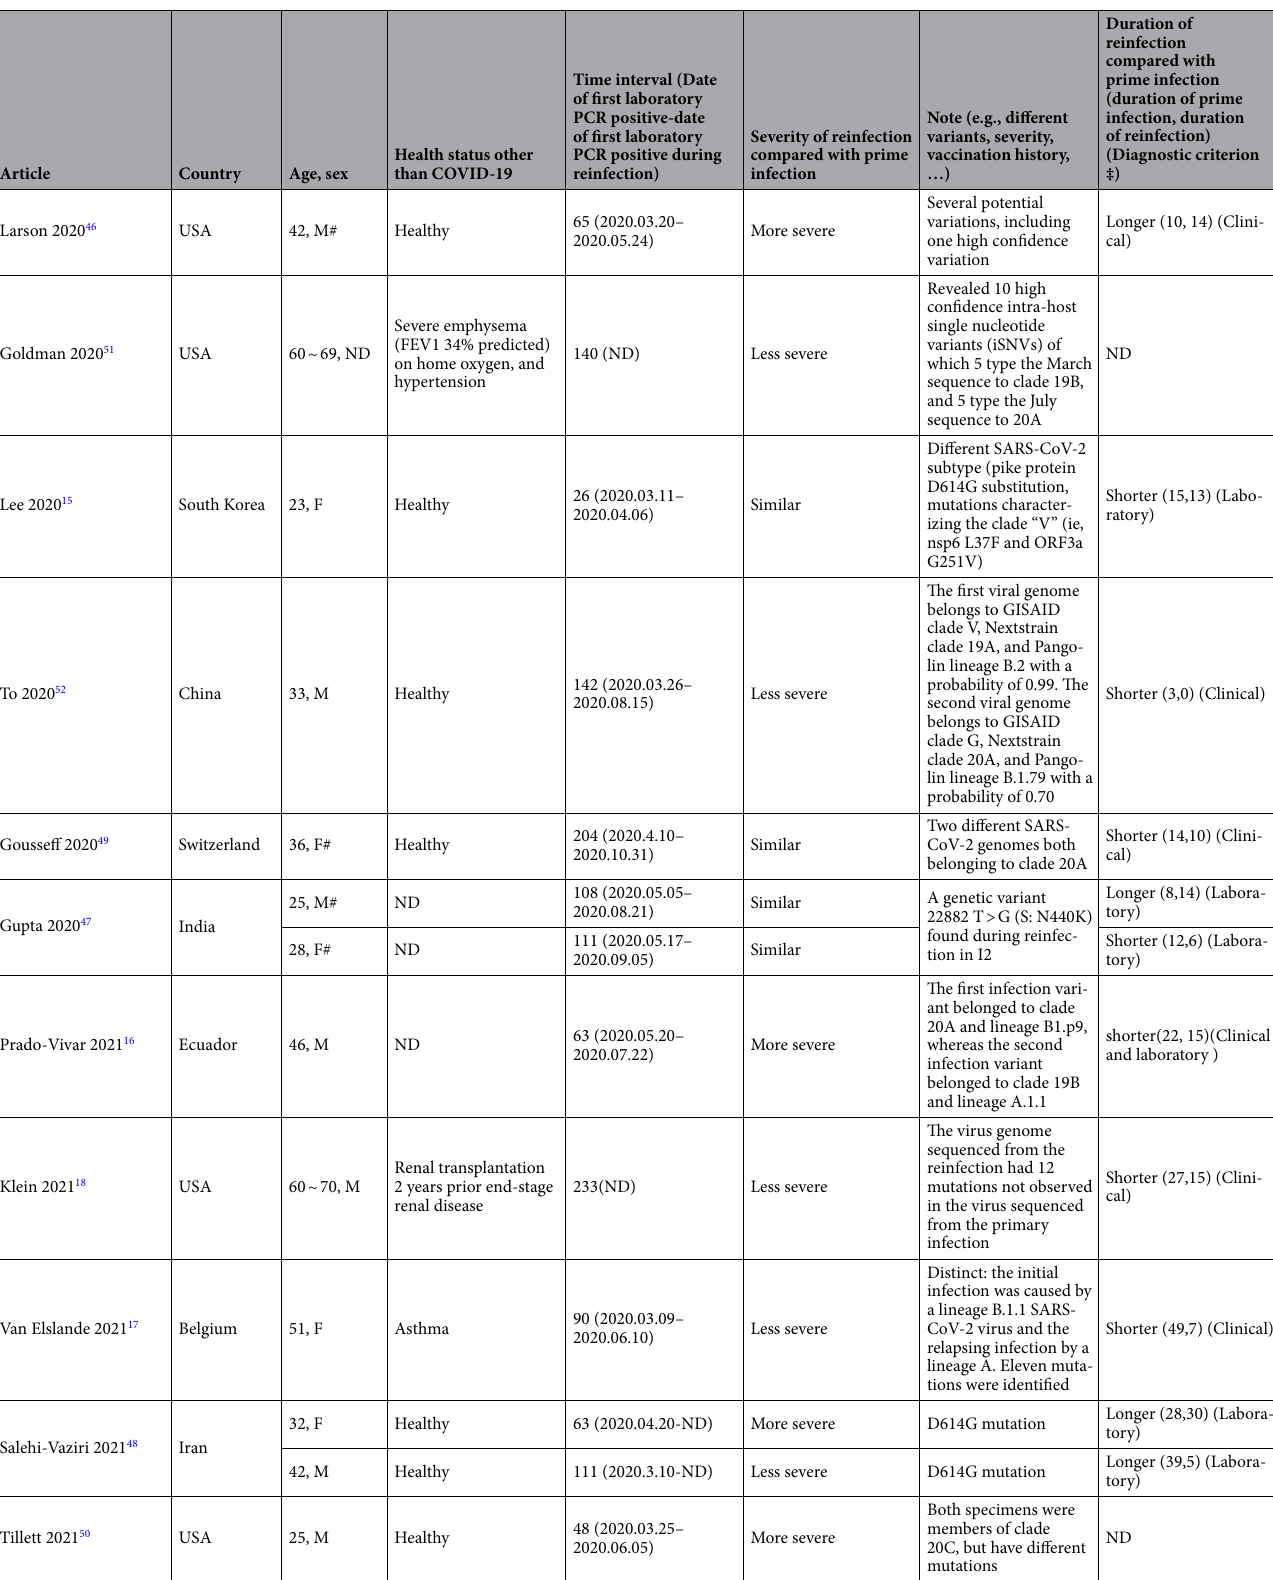
Table 2. Characteristics of included case reports. # Health care workers; ‡Clinical diagnosis such as